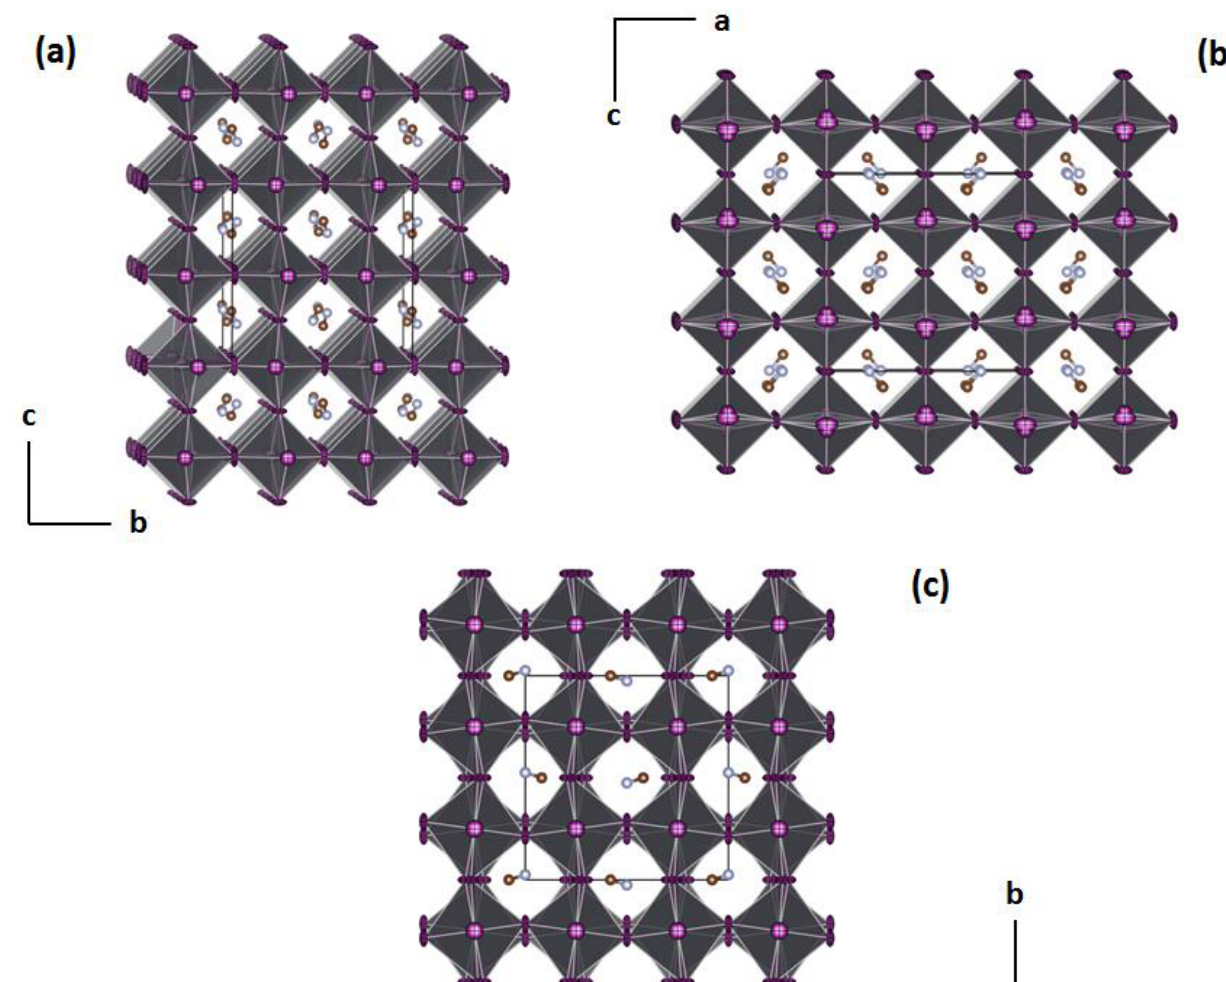
Figure 4. View of the crystal structure of MAPI B seed prepared from a seed obtained in γ -butyrolactone, GBL, with acetic acid as an additive and grown in a solution of formic acid in GBL. Projections of the orthorhombic Fmmm structure down [100] ( a ), down [010] ( b ), and down [001] ( c ). The lattice parameters of crystal C were found to be: a = b = 8.8972(6) Å and c = 12.6214(9) Å. The crystal structure is tetragonal, lattice “ I ”, and was solved in the I 4 cm space group ( R 1 = 0.073, wR 2 = 0.259), introducing the inversion twinning (-100 0-10 00-1). The atomic coordinates of all the atoms were placed as in the structural model of the MAPI grown in the mixture of GBL and acetic acid (crystal A). As in the structure of A, the iodide atom I2 displays positional disorder. It was refined by placing I2 over three sites: I2a, I2b and I2c and fixing their occupancies to 0.33, 0.33 and 0.34, respectively. Both C and N were refined over two symmetrically equivalent sites that occupied 50% each. The remaining residual electron density peaks (+3.10 e · Å − 3 ) were observed at 0.94 Å from